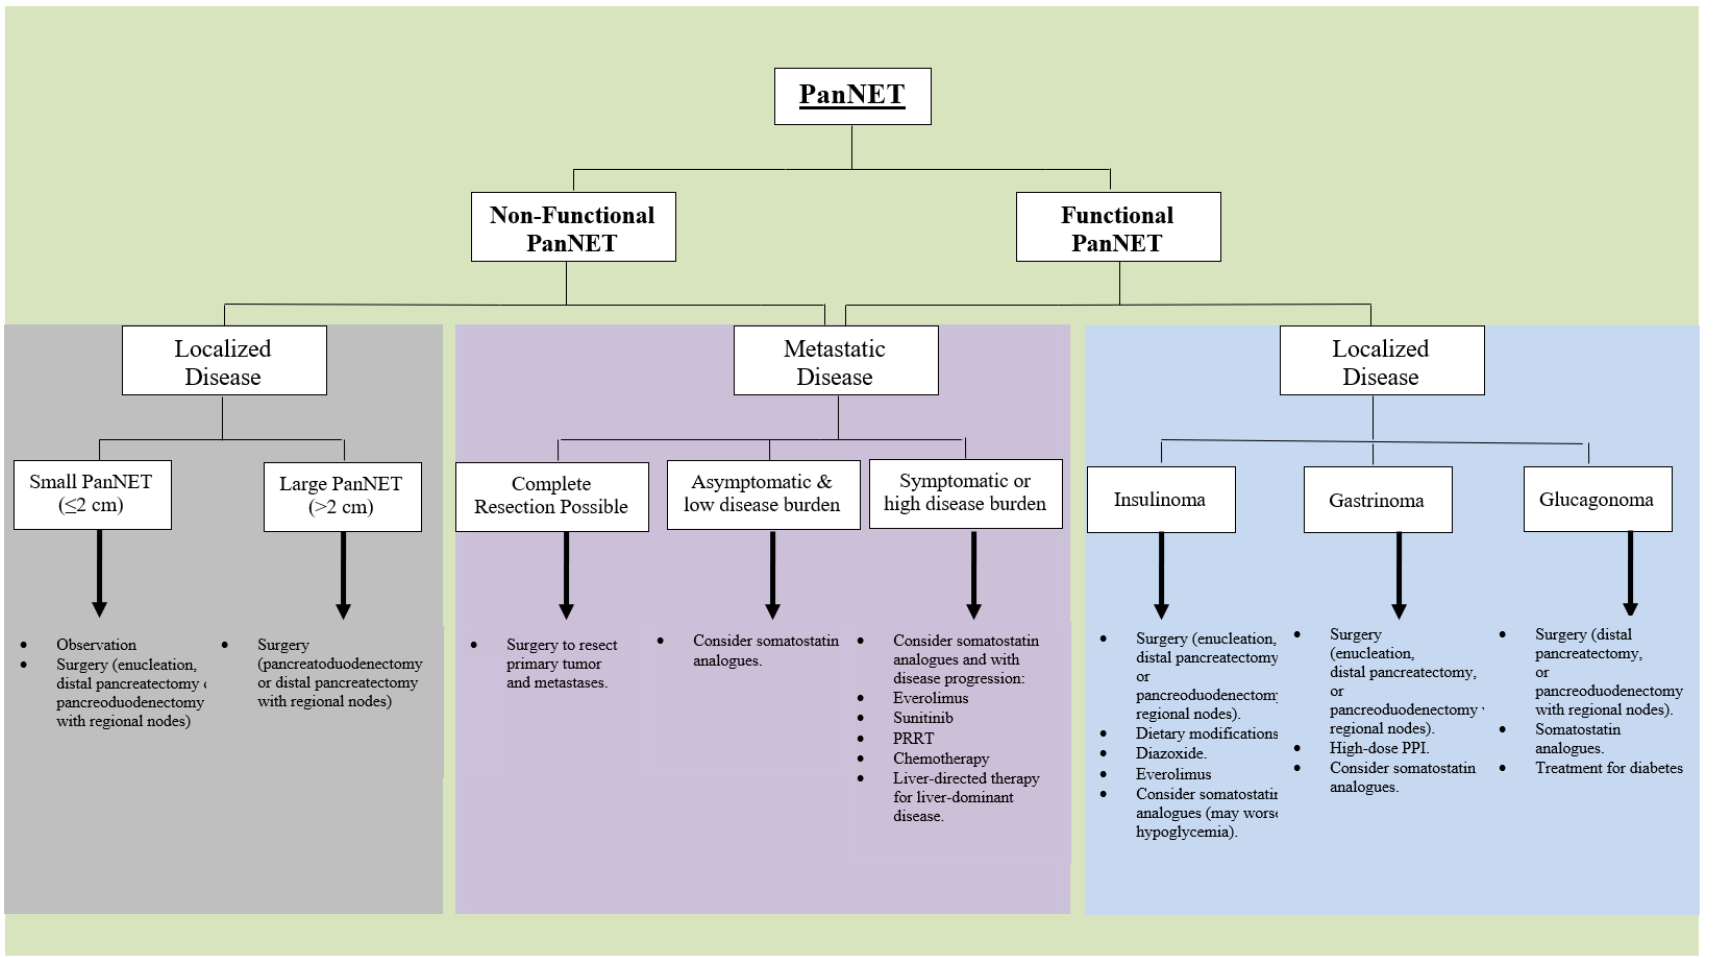
Figure 1. Treatment Algorithm. Suggested treatment algorithm for pancreatic neuroendocrine tumors, based on functionality and localized or metastatic disease.